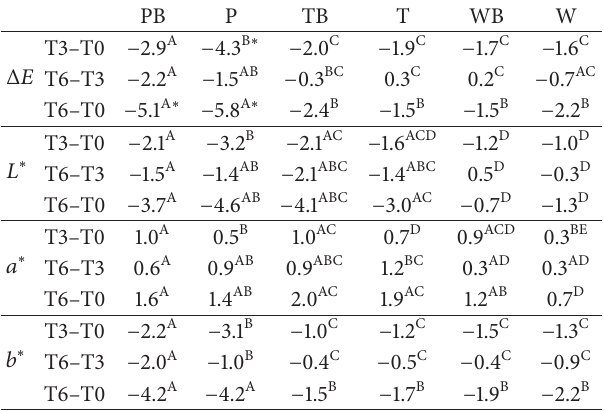
Table 2: Media of Δ𝐸 , 𝐿 ∗ , 𝑎 ∗ , and 𝑏 ∗ at different times among